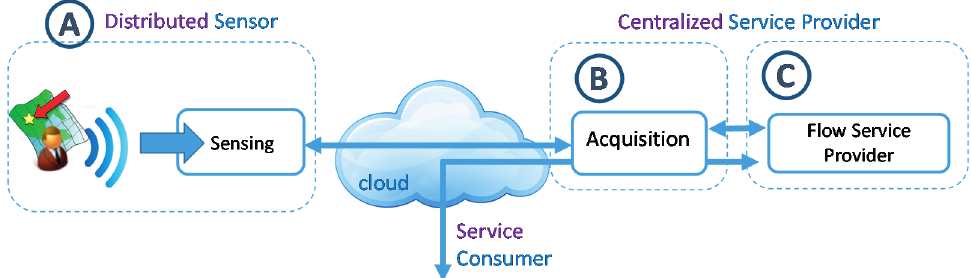
Figure 2. Overall Computational architecture of the citizen track and trace